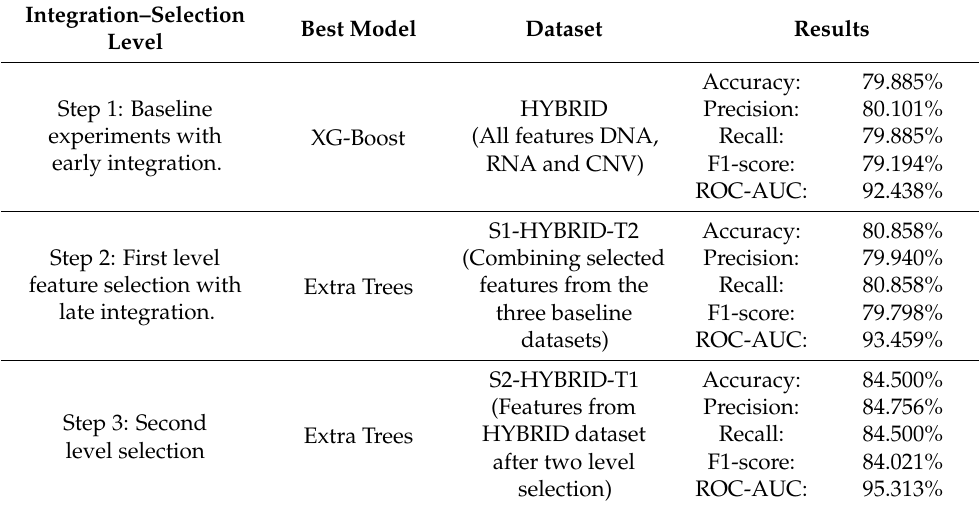
Table 14. Results